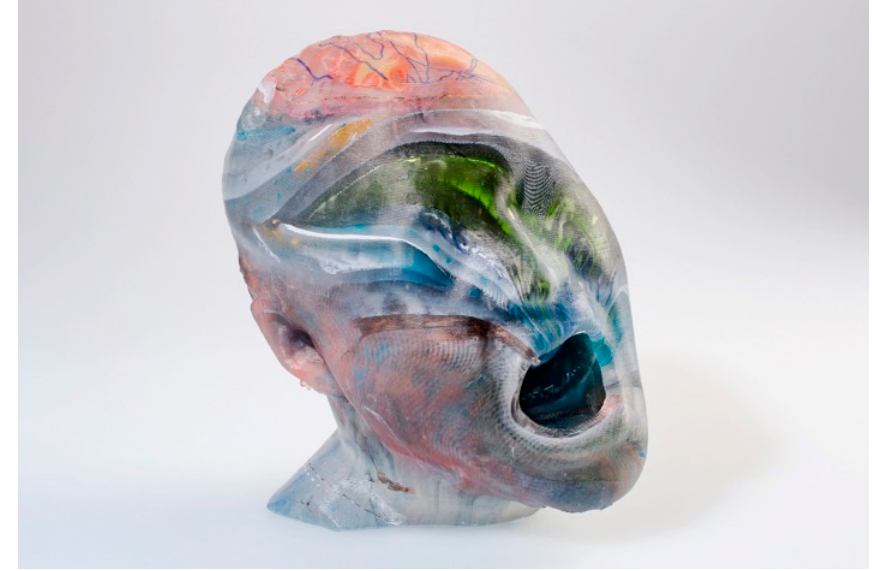
Figure 7. Jeffrey Sarmiento, Encyclopaedia Object 1, 2018 Screenprinted and lost PLA cast glass. A result of the second version of the setup, the mold was partially filled with a cylinder of stacked and screenprinted glass disks. Photo: Bullseye Glass Co.